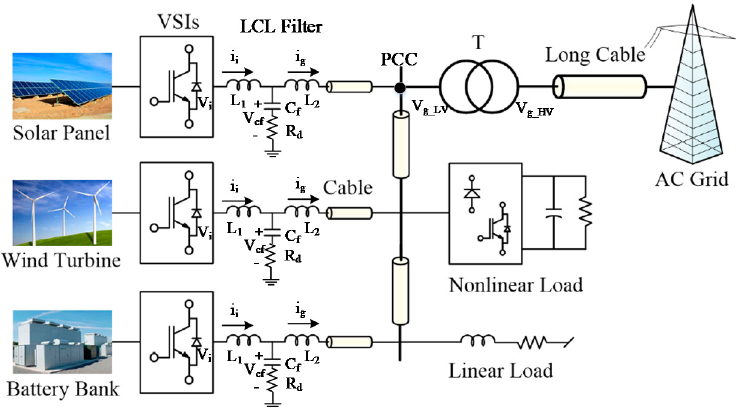
Figure 1. Graphical representation multiple distributed generation (DG) systems interfaced with the main grid [23].